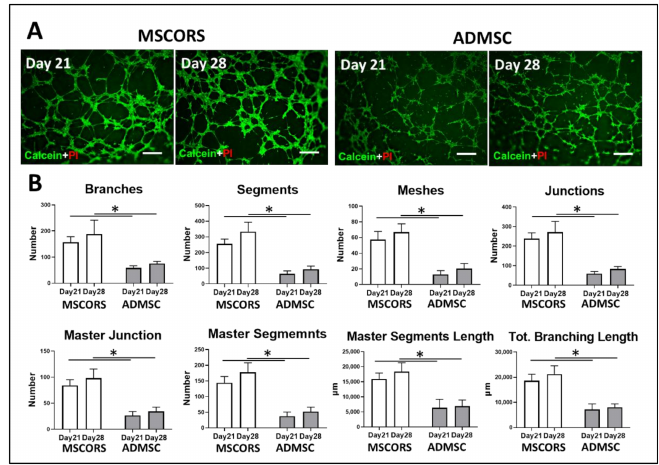
Figure 2. Tube-forming assay of endothelial differentiated mesenchymal stem cells from the outer root sheath (MSCORS) and adipose-derived mesenchymal stem cells (ADMSC) with quantitative analysis. The angiogenic functionality of the differentiated endothelial cells from MSCORS and ADMSC were investigated using tube-forming assay to assess the potential for anastomosis. ( A ) Microphotographs of anastomotic network generated by differentiated MSCORS and ADMSCs. Both MSCORS and ADMSC formed interconnected network of anastomotic tubes after endothelial differentiation, with living cells stained by green fluorescence and dead cells stained in red (scale bar 250 µ m; magnification 4 × ). ( B ) Quantitative analysis of sprouting angiogenesis on Matrigel-based tube-forming assay using ImageJ Angiogenic Analyzer in the given parameters. Results are shown as mean ± SD. (* p < 0.05).